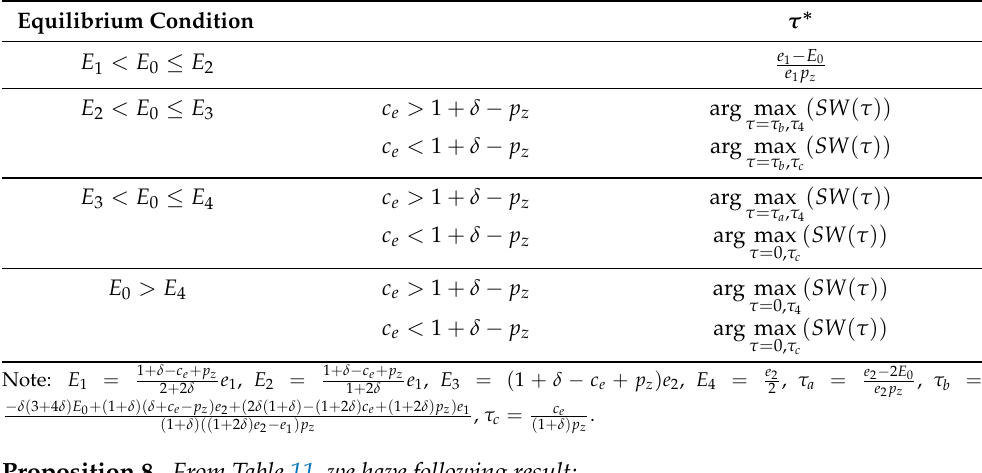
Table 11. The optimal decision on τ